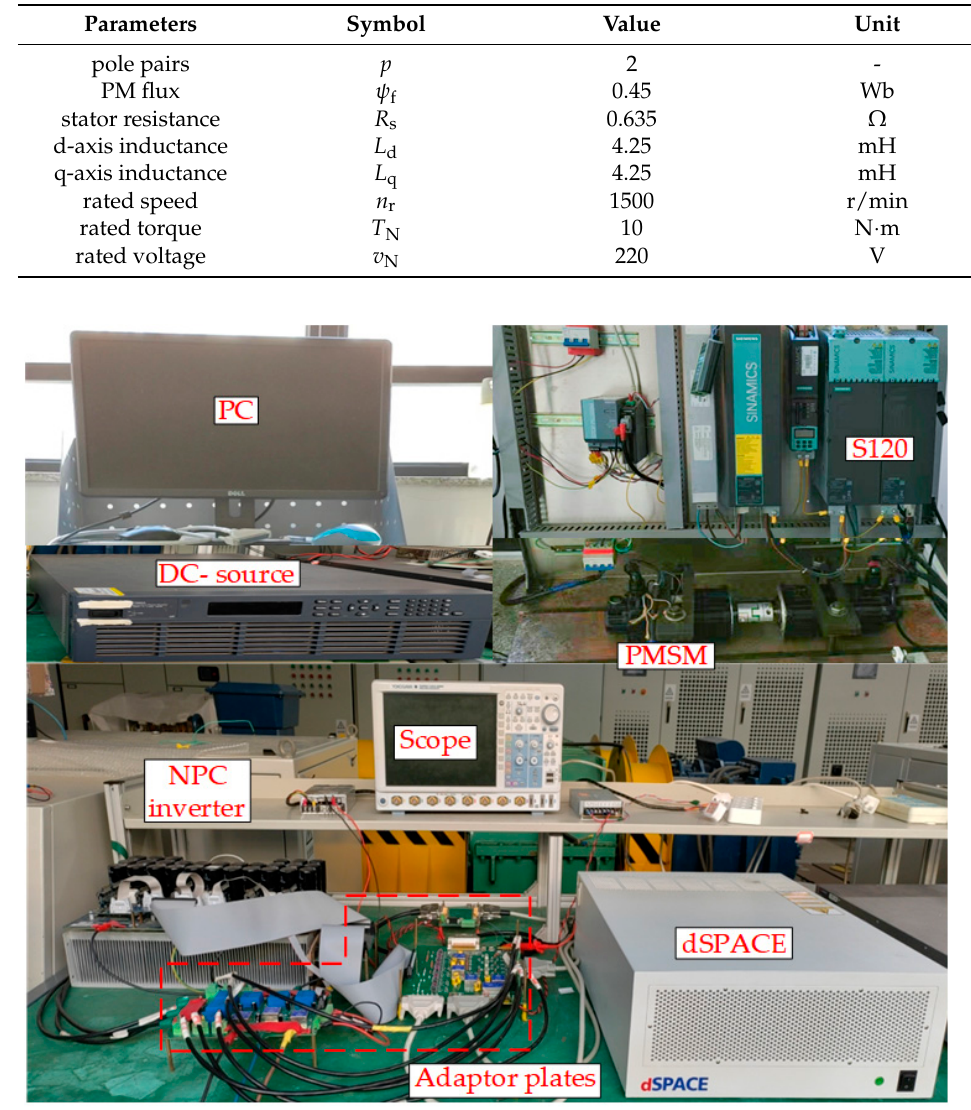
Figure 10. Experimental